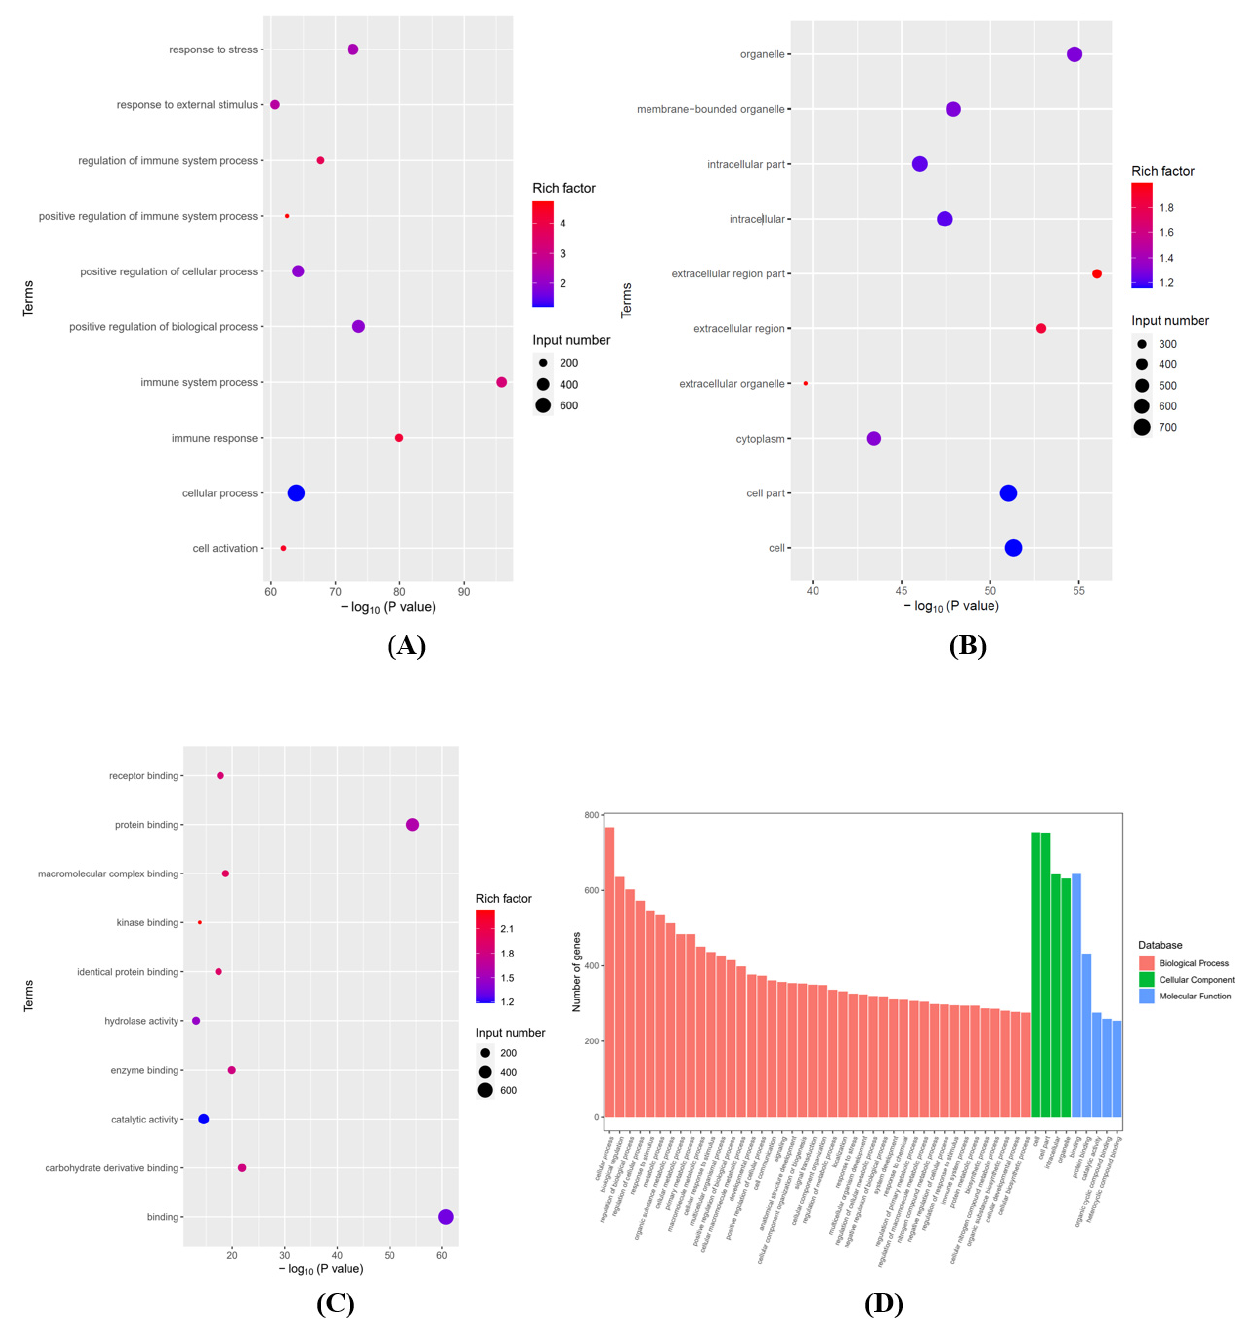
Figure 3. ( A ) The top 10 significantly enriched BP terms of up-regulated mRNA. ( B ) The top 10 significantly enriched CC terms of up-regulated mRNA. ( C ) The top 10 significantly enriched MF terms of up-regulated mRNA. ( D ) Integrated some significant BP, CC, and MF terms and shows them in a bar graph.